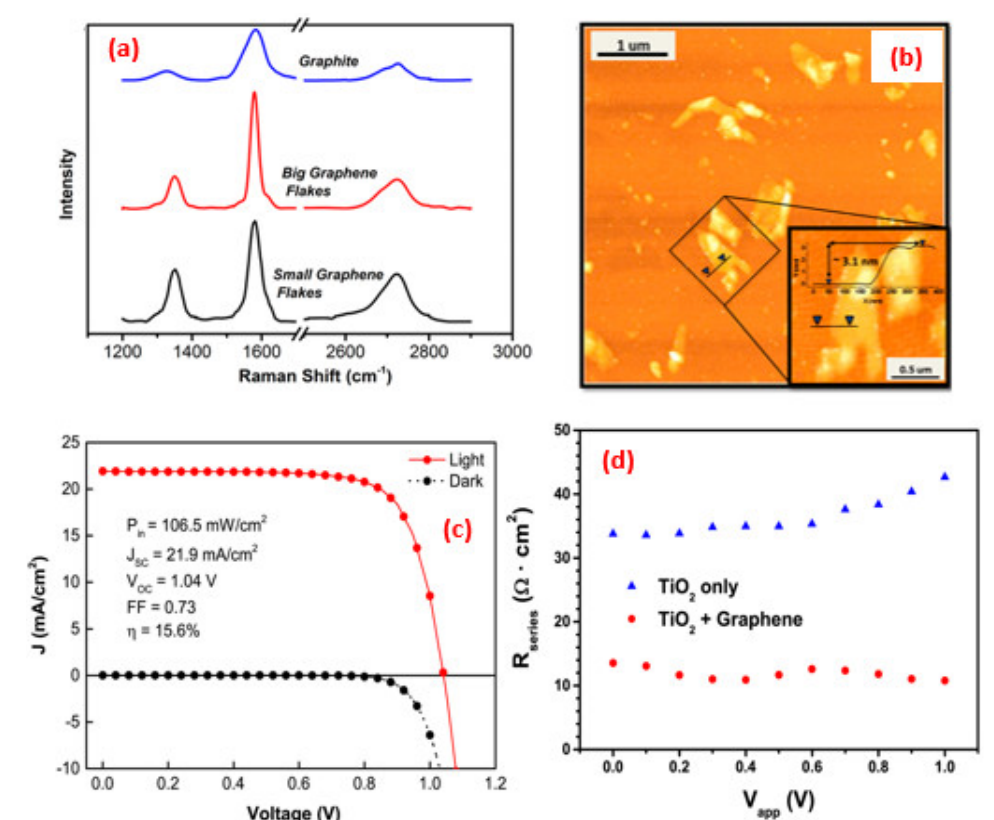
Figure 11. ( a ) Raman spectra of starting graphite flakes and exfoliated graphene deposited on the SiO 2 substrate with increasing sonication time. ( b ) AFM image of exfoliated graphene scanned at 5 µ m × 5 µ m and enlargement of the graphene flakes. ( c ) The best-performing ( η = 15.6%) solar cell based on graphene–TiO 2 nanocomposites under simulated AM1.5, 106.5 mWcm − 2 solar irradiation (solid line), and in the dark (dotted line), which were processed at temperatures not exceeding 150 ◦ C. ( d ) Series resistance R series obtained from impedance spectroscopy analysis of samples with two different concentrations of graphene mixed with TiO 2 in the electron collection layer. Copyright 2014 by the American Chemical Society [139].